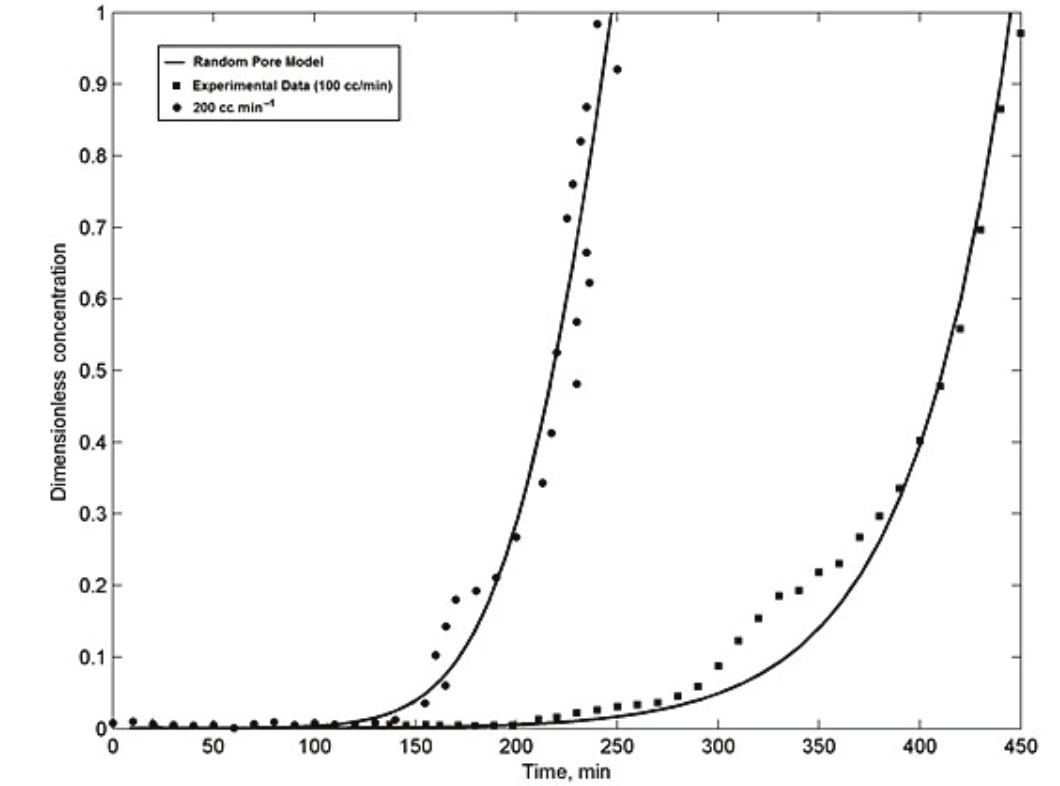
breakthrough curves from MgO packed bed reactor 2